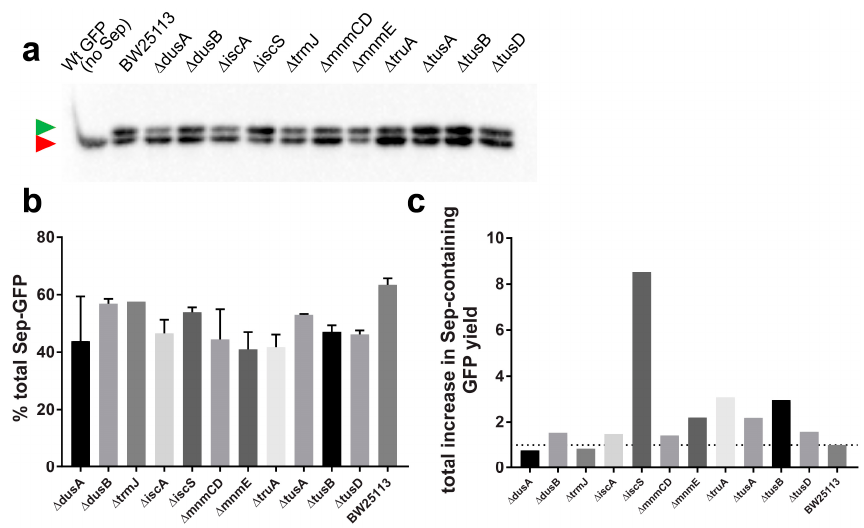
Figure 4. Some of the deletion strains showing increased GFP-2TAG synthesis while preserving the relative Sep-GFP to cAA-GFP ratio. ( a ) Phos-tag TM mobility shift analysis of GFP-2TAG isolated from the corresponding knockout strains. Strain names are indicated above the wells. Proteins were analyzed by the Phos-tag method and detected by Western blot using anti-GFP antibodies. The green arrow shows the position of the Sep-containing GFP, while the red one points to the position of nonphosphorylated, cAA-containing GFP. Wild-type GFP controls are also shown. ( b ) Quantification of the shifted bands allows the estimation of Sep incorporation efficiency. Percentages of Sep-modified GFP in the corresponding isolate are shown. Values are presented as mean ± S.D. derived from two biological replicates. ( c ) Mean increase in total GFP-2TAG synthesis (Figure 3,